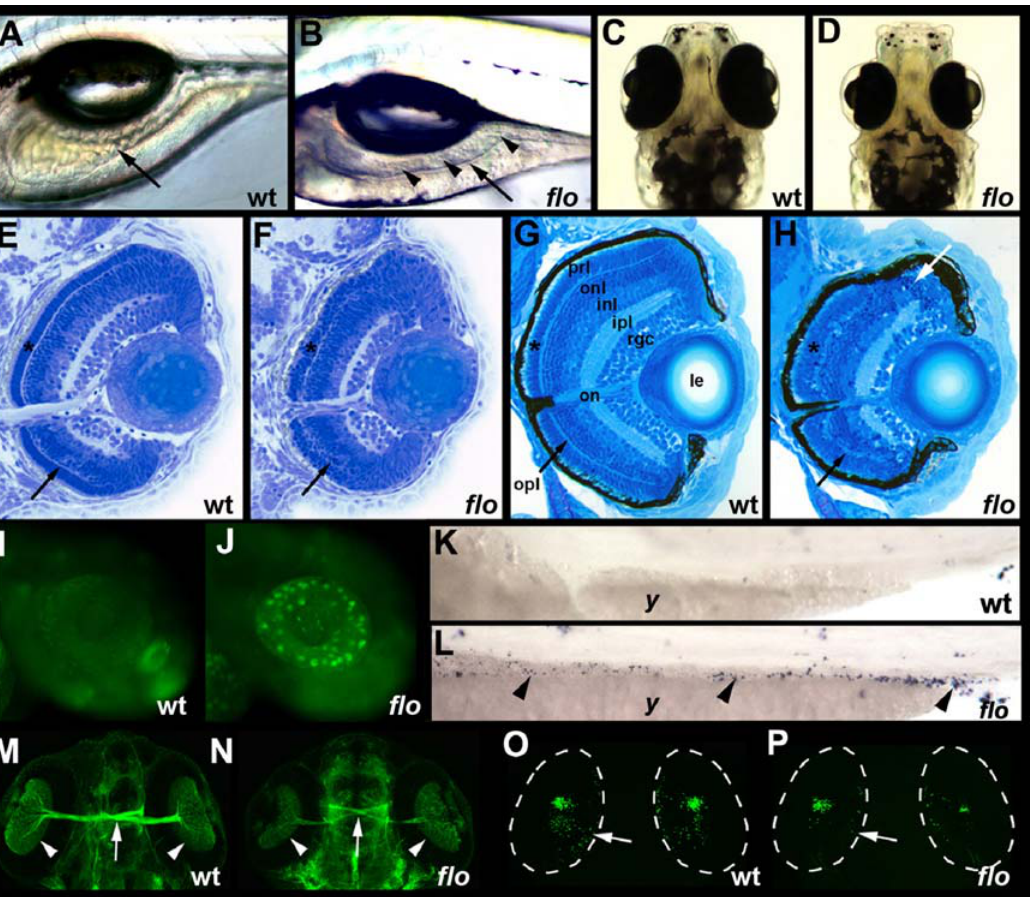
Figure 1. flo intestinal and retinal defects. (A,B) Lateral view of live 5 dpf wild type (wt) and flo larvae. The flo intestine lacks folds (arrow) and the lumen contains detached epithelial cells (arrowheads). (C,D) Dorsal view showing reduced size of the 5 dpf flo eye. (E,F) Histological cross section showing cells with condensed nuclei typical of apoptotic cells in the 60 hpf flo retina, and disorganization of the flo photoreceptor (*) and outer plexiform (arrow) layers. (G,H) Histological cross section showing marked disorganization of the 4 dpf flo retina and cells with condensed nuclei typical of apoptotic cells (white arrow). (I,J) Acridine orange staining showing apoptotic cells in the 48 hpf flo retina but not sibling wild types. (K,L) TUNEL staining showing apoptotic cells in the 75 hpf flo intestine (arrowheads) but not sibling wild types (anterior–left, posterior–right). (M,N) Dorsal view showing mild reduction in the number of flo retinal ganglion cells (arrowheads) and optic nerve diameter (arrow) identified with the Zn5 antibody. (O,P) Confocal projection of immunostained wt and flo larvae showing reduced rod cells in the flo retina including the large ventral cluster of cells and in the periphery of the mid retina (arrow). onl, outer nuclear layer; inl, inner nuclear layer; ipl, inner plexiform layer; rgc, retinal ganglion cell layer; on, optic nerve; le, lens; y,